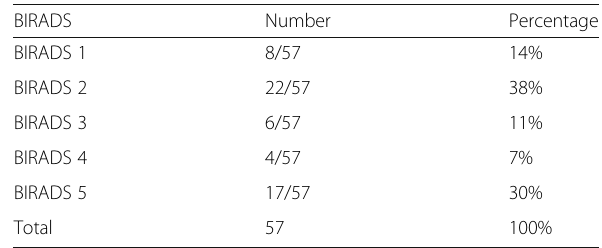
Table 5 showing the BI-RADS categories by breast ultrasound BIRADS